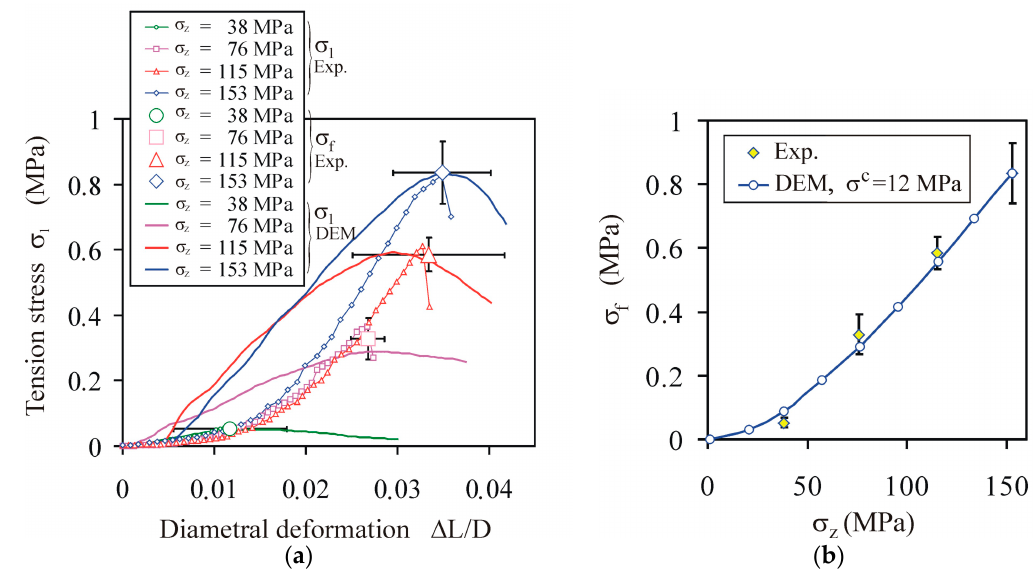
Figure 13. Experimental and DEM-simulated relationships: ( a ) tension stress σ 1 vs. deformation ∆ L / D ; ( b ) tensile strength σ f vs. compaction pressure. The bars indicate the standard deviation.